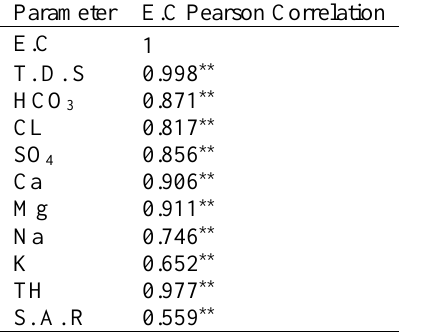
Table 5. Results of Pearson's